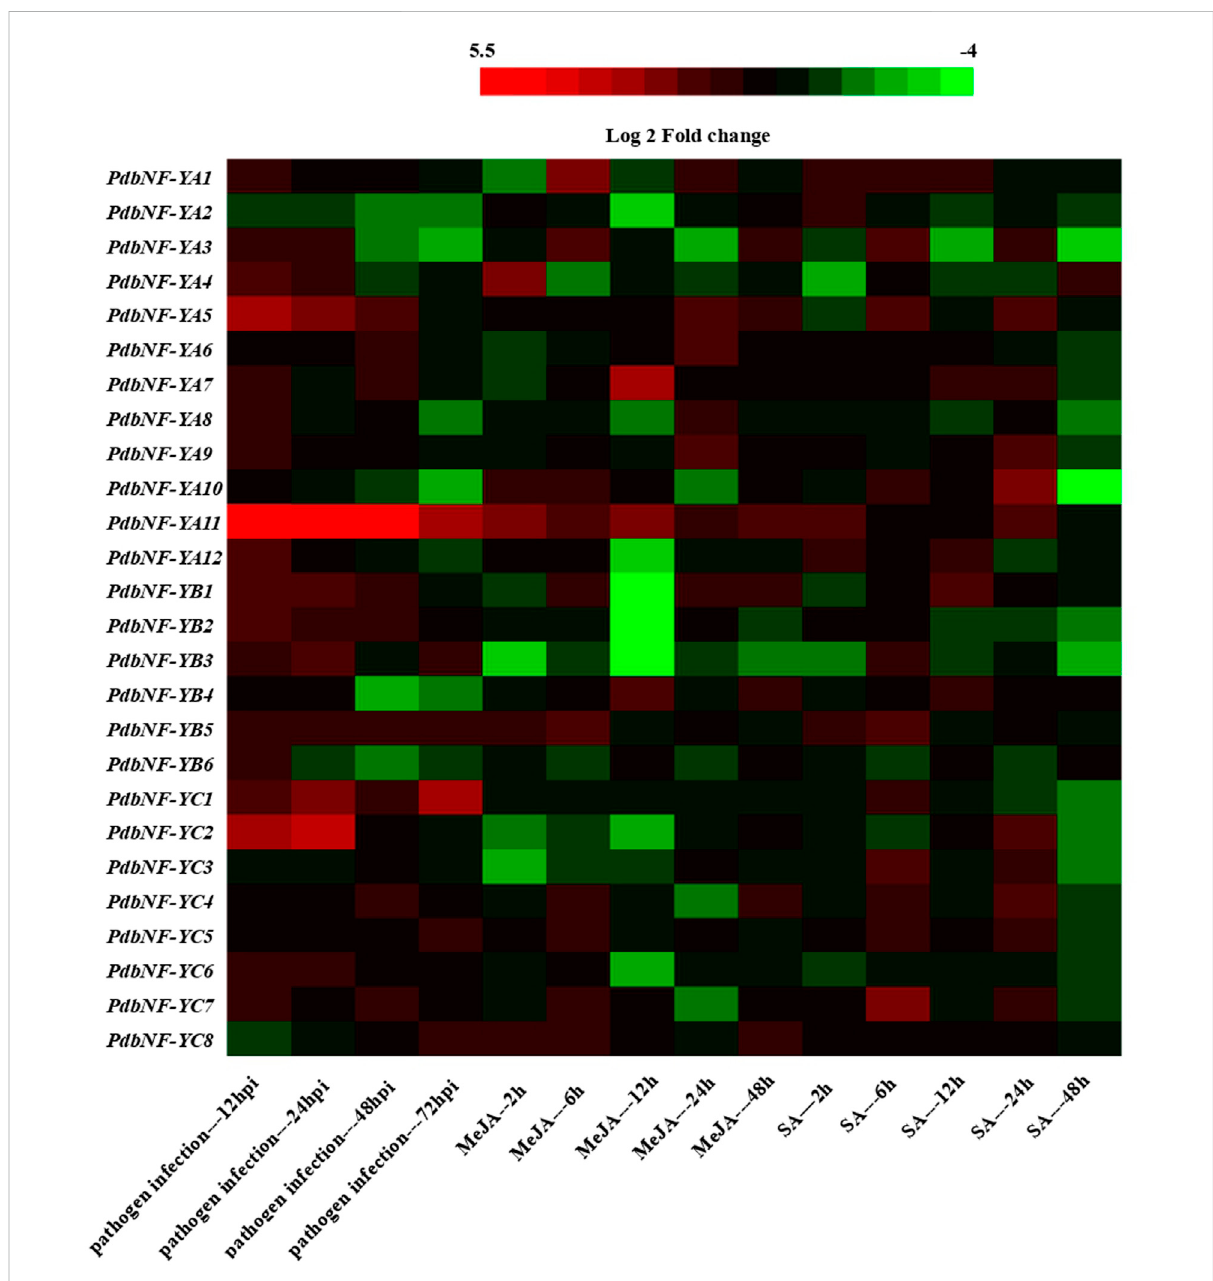
FIGURE 7 Heatmap of PdbNF-Y s expression under biotic stresses. The log 2 fold change was colored using Cluster 3.0 (red for upregulated and green for downregulated). Each horizontal row represents a gene, and the vertical columns represent time points.